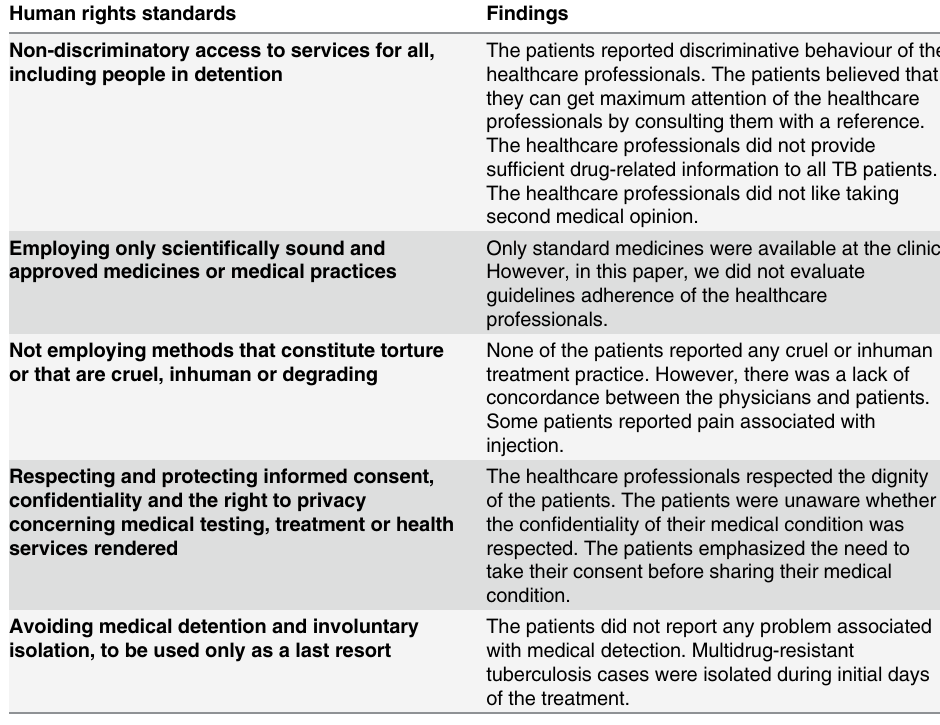
Table 3. The Global Fund minimum human rights